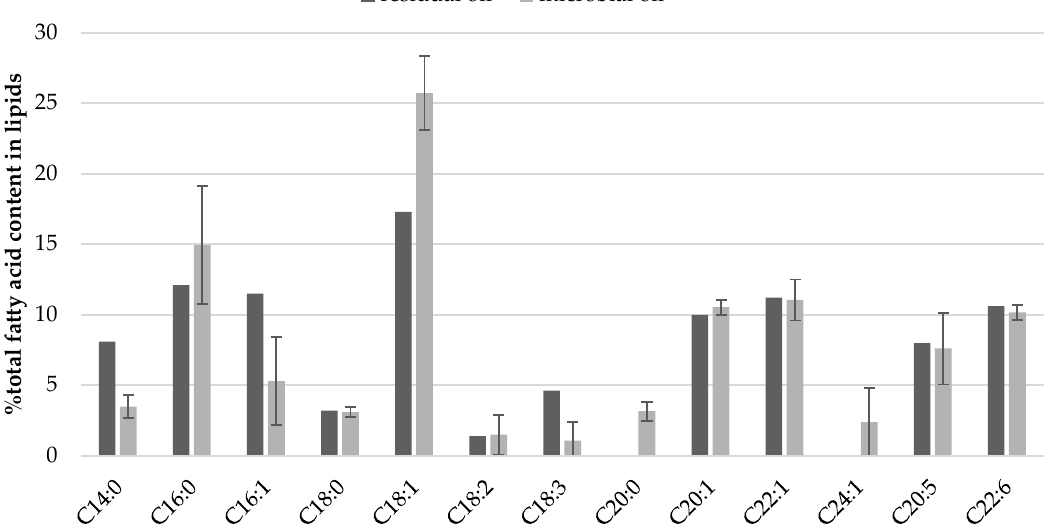
Figure 4. Comparison on biomass yield and cellular lipids amount isolated from yeast biomass cultured in batch bioreactor differing in carbon source in medium (olive oil—MO5 or waste fish oil—MF5) and amount of inoculum (0.0025% v/v— 1; 0.0075% v/v— 2).